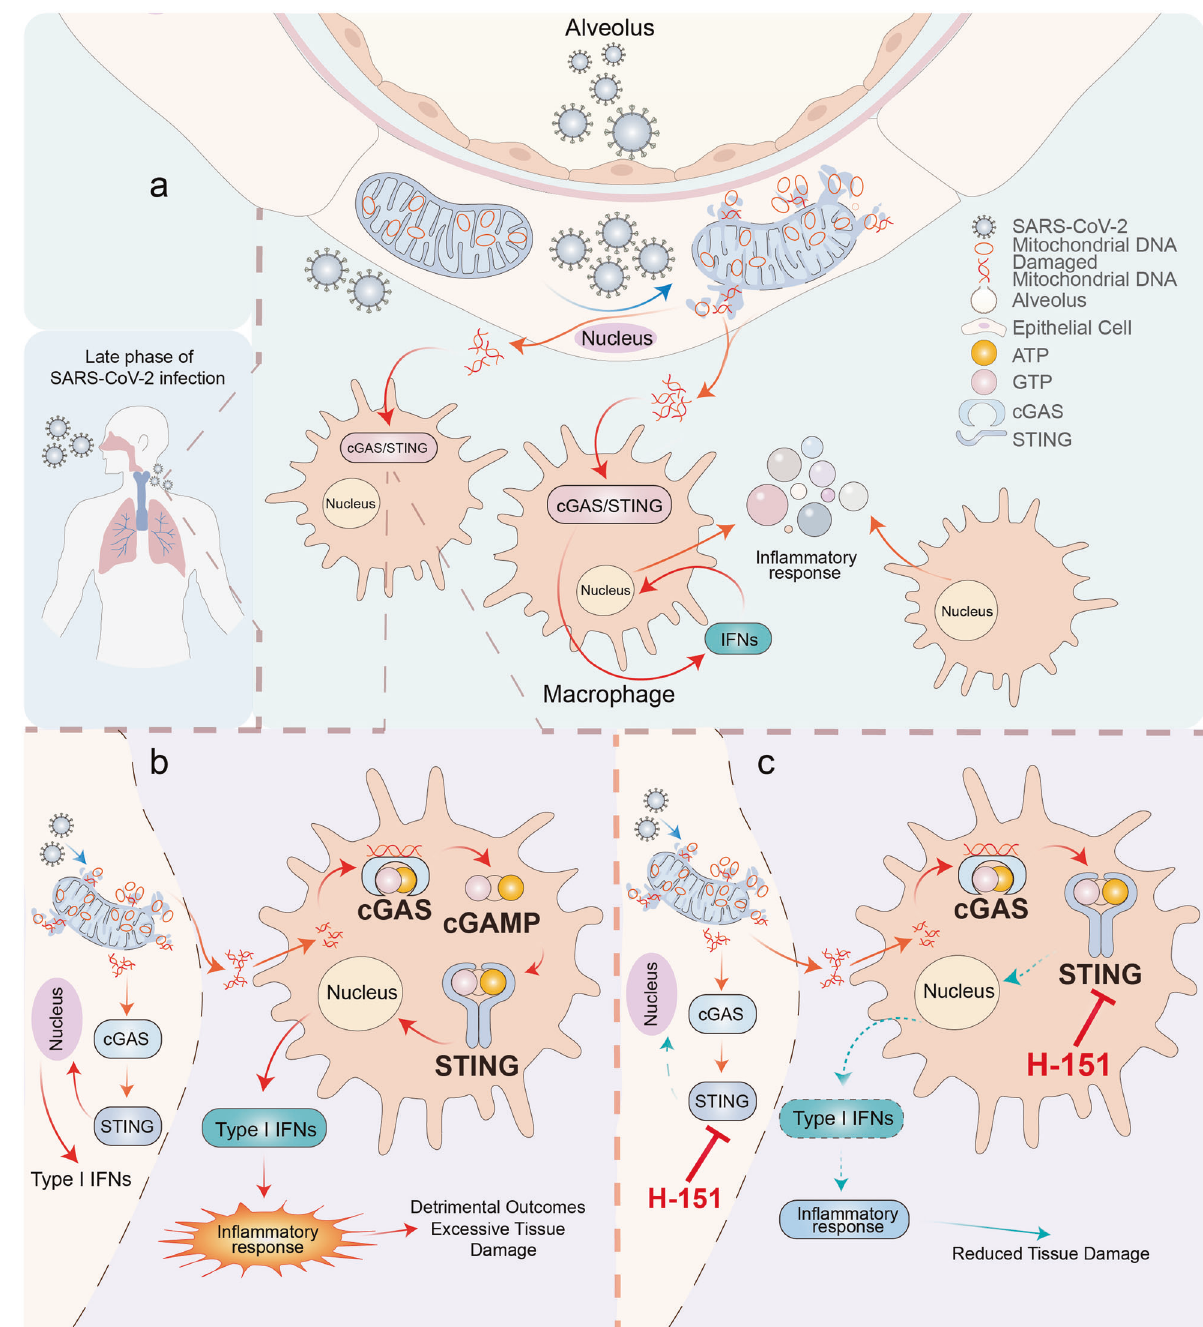
Fig. 1 The contributing role of STING in in fl ammatory responses during the late phase of SARS-CoV-2 infection. a The late phase of SARS-CoV- 2 infection causes mitochondrial damage in epithelial cells, resulting in the accumulation of mitochondrial DNA (mtDNA) in the cytosol. Furthermore, large amounts of mtDNA activate the cGAS-STING pathway excessively, leading to the death of epithelial cells. When macrophages engulf the dead cells debris at the vessel lesions, mtDNA triggers cGAS-STING signaling. As a result, macrophages produce a large amount of type 1 interferon (IFN), causing a robust in fl ammatory response. The dysregulated cytokine responses drive immunopathology, including tissue damage and acute body harm. b , c STING plays a central role in in fl ammation, and the small-molecule STING inhibitor H-151 exerts great effects in relieving the immunopathology response and ameliorating the lung pathology at the late stage of SARS-CoV-2 infection response at the alveolus-capillary interface in the late phase of the cGAS-STING signaling pathway and driving immunopathology. infection. These fi ndings were of great signi fi cance for the in-depth For the fi rst time, these researchers clari fi ed that SARS-CoV-2 understanding of the cGAS-STING pathway activation during infection promotes mitochondrial damage and mtDNA leakage in COVID-19 pathology. Additionally, it was the fi rst time that a STING endothelial cells. More importantly, the study provided a new perspective regarding SARS-CoV-2 infection and aberrant immune Signal Transduction and Targeted Therapy (2022)